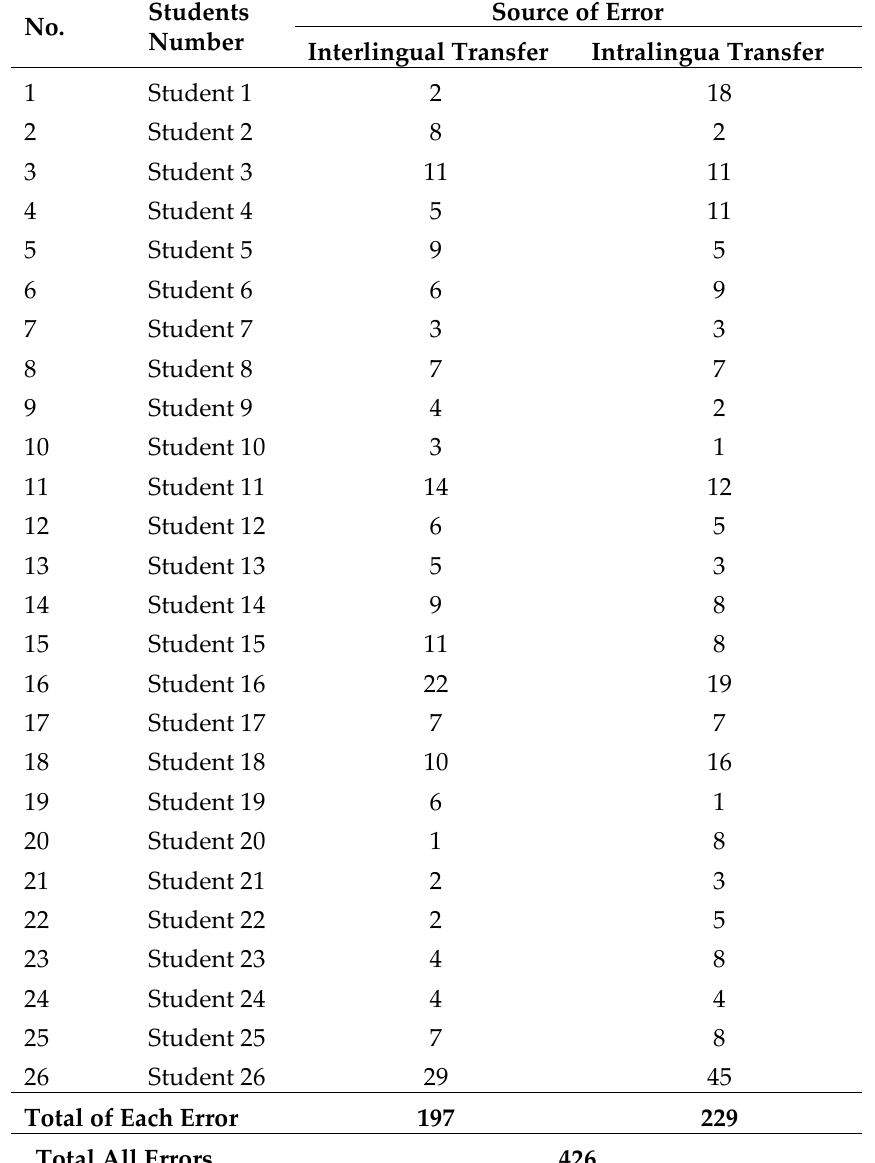
Table 4.3 The Recapitulation of Source of Student’s Errors